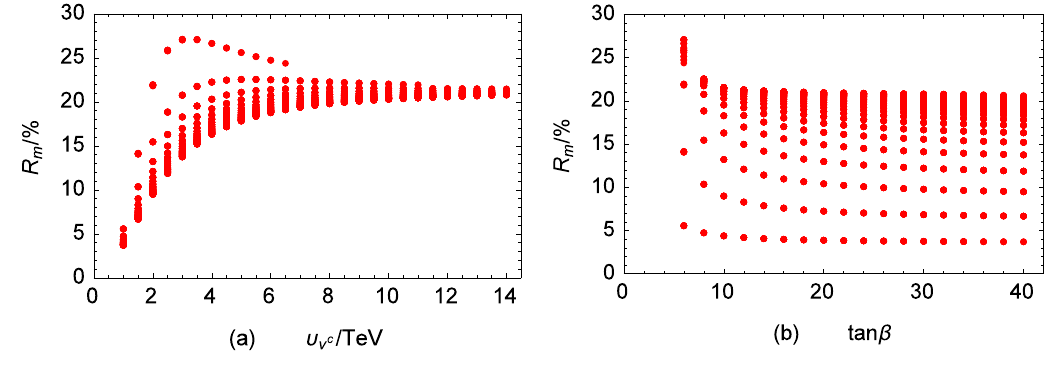
Figure 4 . R m varies with (cid:29) (cid:23) c (a) and tan (cid:12)